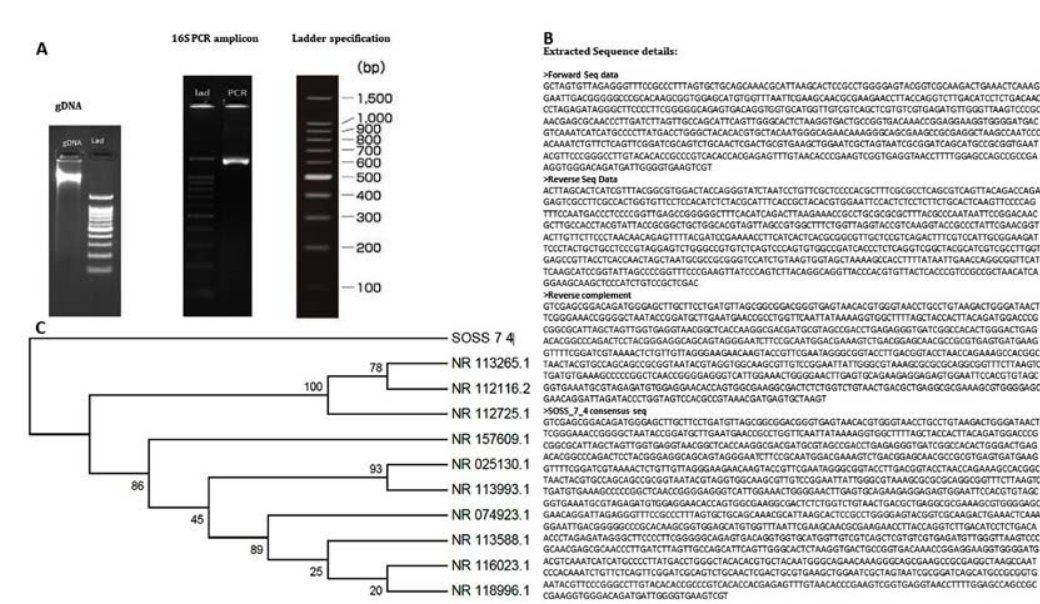
Fig.7. (A) PCR amplification of isolated sample SOSS_7_4. (B) Sequencing result of the DNA of the sample. (C) Development of a phylogenetic tree for sample identification. The consensus sequence was used for species identification and BLAST analysis was done for both the sequences generated. The results of the top 10 BLAST hits are presented in Table 1 and Table 2 (sample POSS_8_2 and